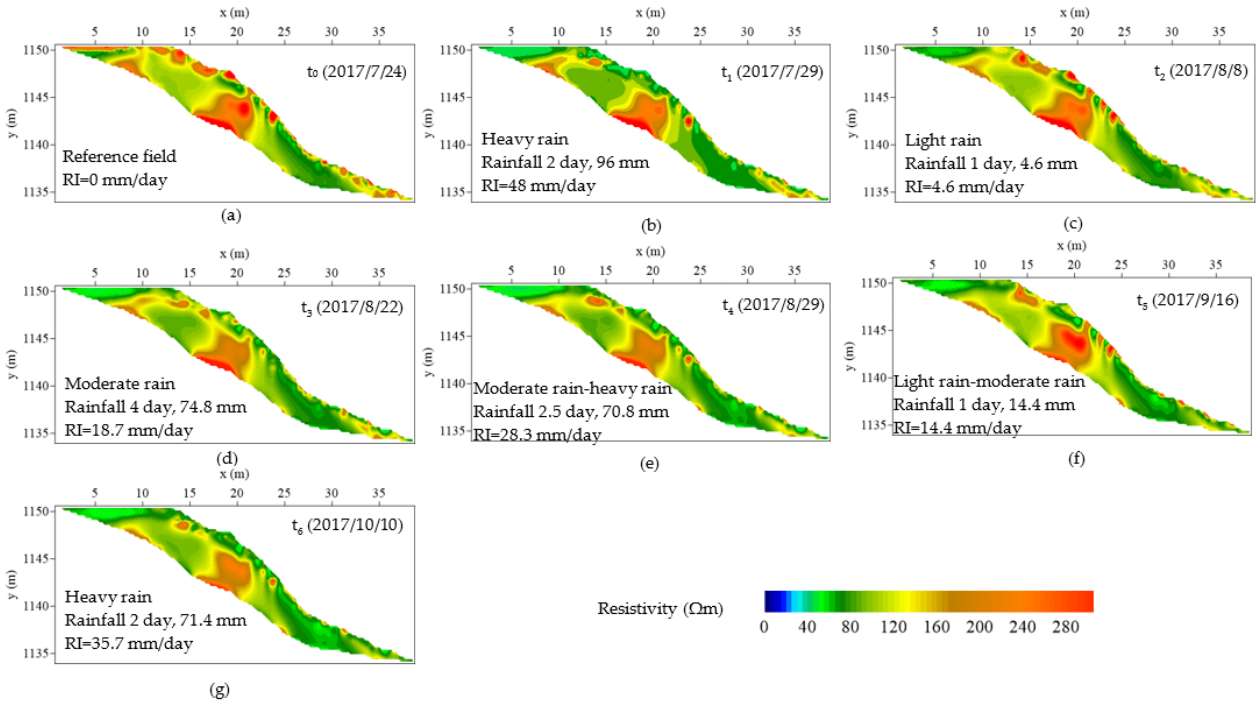
Figure 7. Temperature corrected 2D apparent resistivity model sections (x = Distance, y = Eleva- tion). ( a – g ) is the distribution of slope apparent resistivity field under different rainfall conditions.